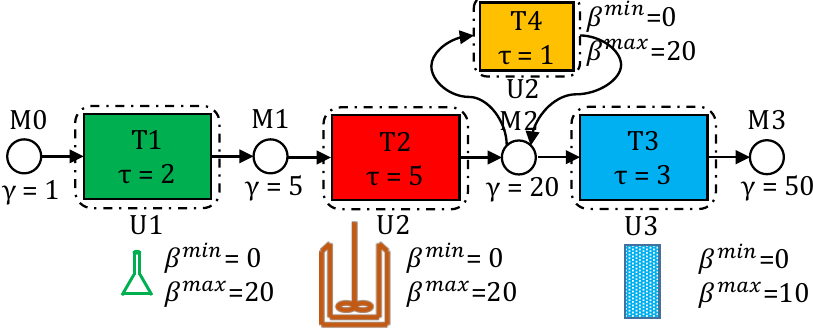
Figure 1. STN representation of a process network. This network, for a bio-manufacturing process, is described in detail in Section 5. It has three steps (tasks) for production of a pharmaceutical ingredient (material M3). T1 is the task of preparing the cell cultures in lab-size beakers. T2 denotes the task of having the cell culture grow and produce the pharmaceutical active ingredient, on a feed of sugars, in a bio-reactor. T3 is a purification task, which is carried out in chromatograph columns. Finally, T4 is a dummy task to model storage of material M2 inside unit U2. ρ ik / ¯ ρ ik values (not shown in the figure) are either − 1 or + 1 depending on whether the task is consuming the material or producing